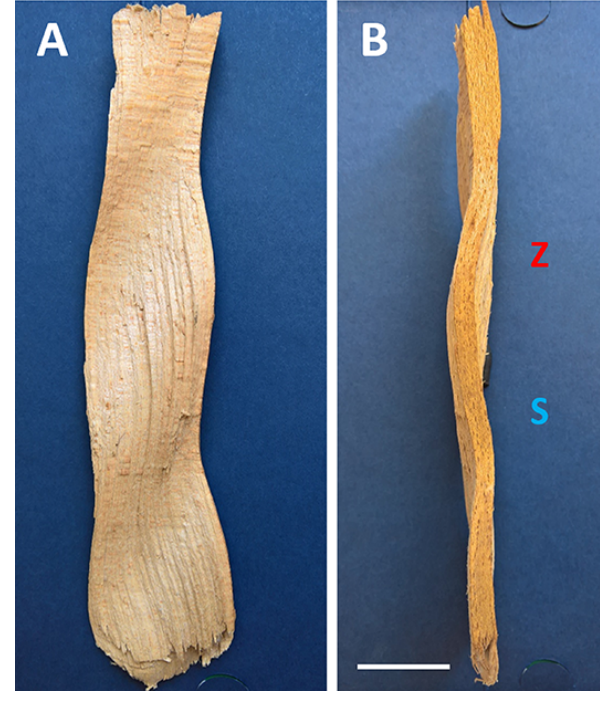
Figure 5 Radial ( A ) and tangential ( B ) face of a splinter detached from the rippled beech wood showing spatial-temporal dynamics and superposition of R-wave and T-wave; synchronized movement of both waves is acropetal; ( A ) wood grain, inclined initially towards the pith changes inclination continuously towards the surface of the stem (here on the right side of the sample) or vice versa; this way crests give way to throughs and throughs to crests while moving upward; ( B ) tangential view of grain deviations from the vertical axis to the le (S) and the right (Z) in the outermost wood layer; they result from the presence of transverse T-wave; vertical sequence of the areas with opposite grain orientation atop of the crest is Z/S; the upper edge of the splinter is apical. Scale bar: 22 mm, the same for ( A ) and ( B ).